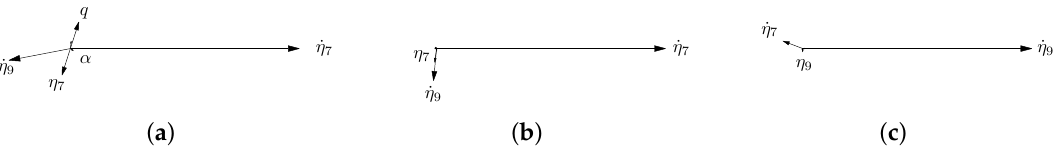
Figure 8. Eigenvector phasor diagrams for the identified model: ( a ) short period (SP) mode; ( b ) first symmetric wing bending (SW1B) mode; and ( c ) first symmetric wing torsion (SW1T)